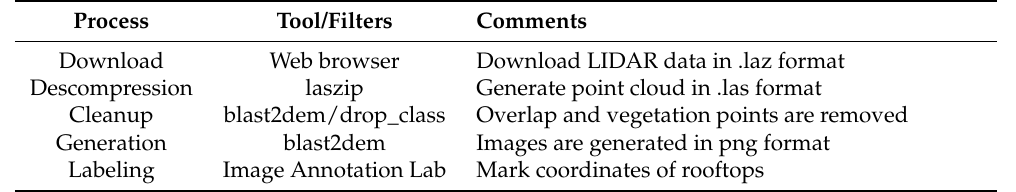
Table 1. Process for generating an image set using LIDAR